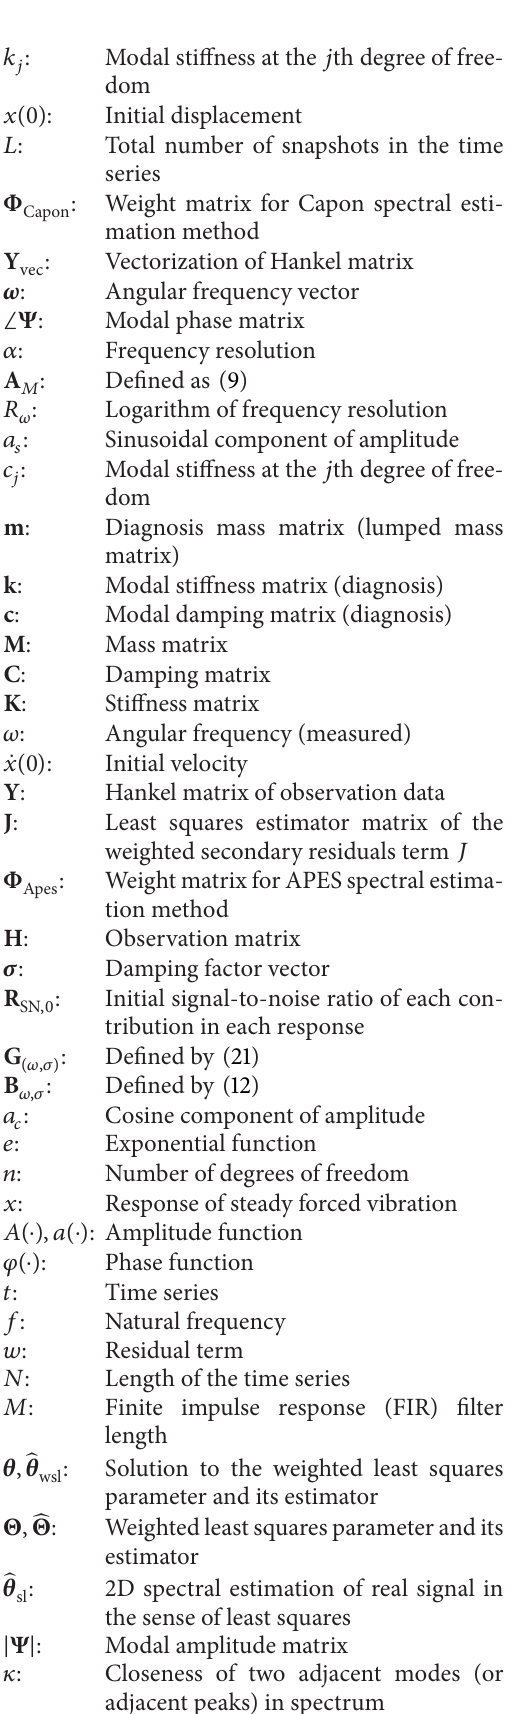
2D spectral estimation of real signal